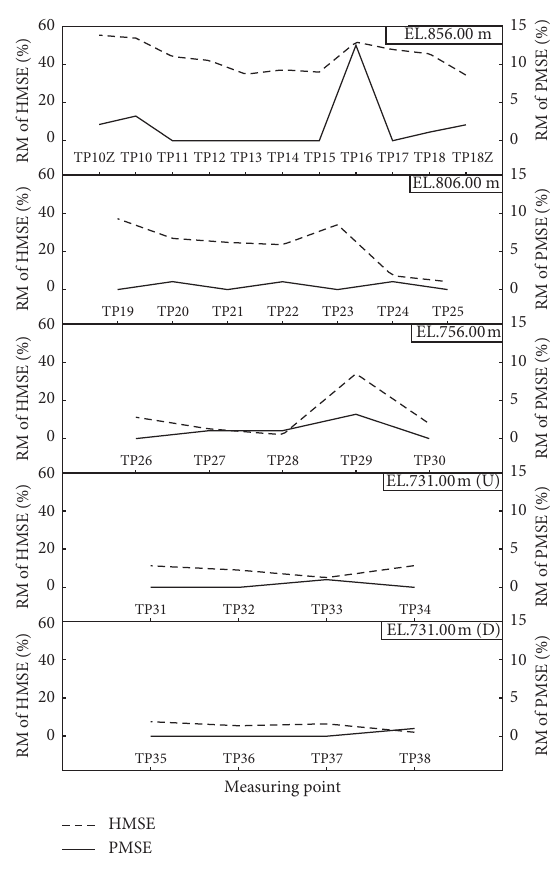
Figure 9: RM of HMSE and